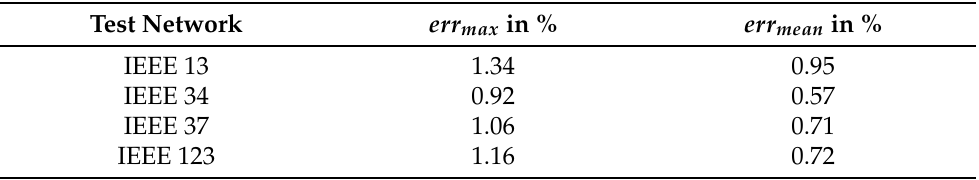
Table 4. Maximum and average percentage errors (absolute amounts) for estimated nodal voltage magnitudes (Step A2).